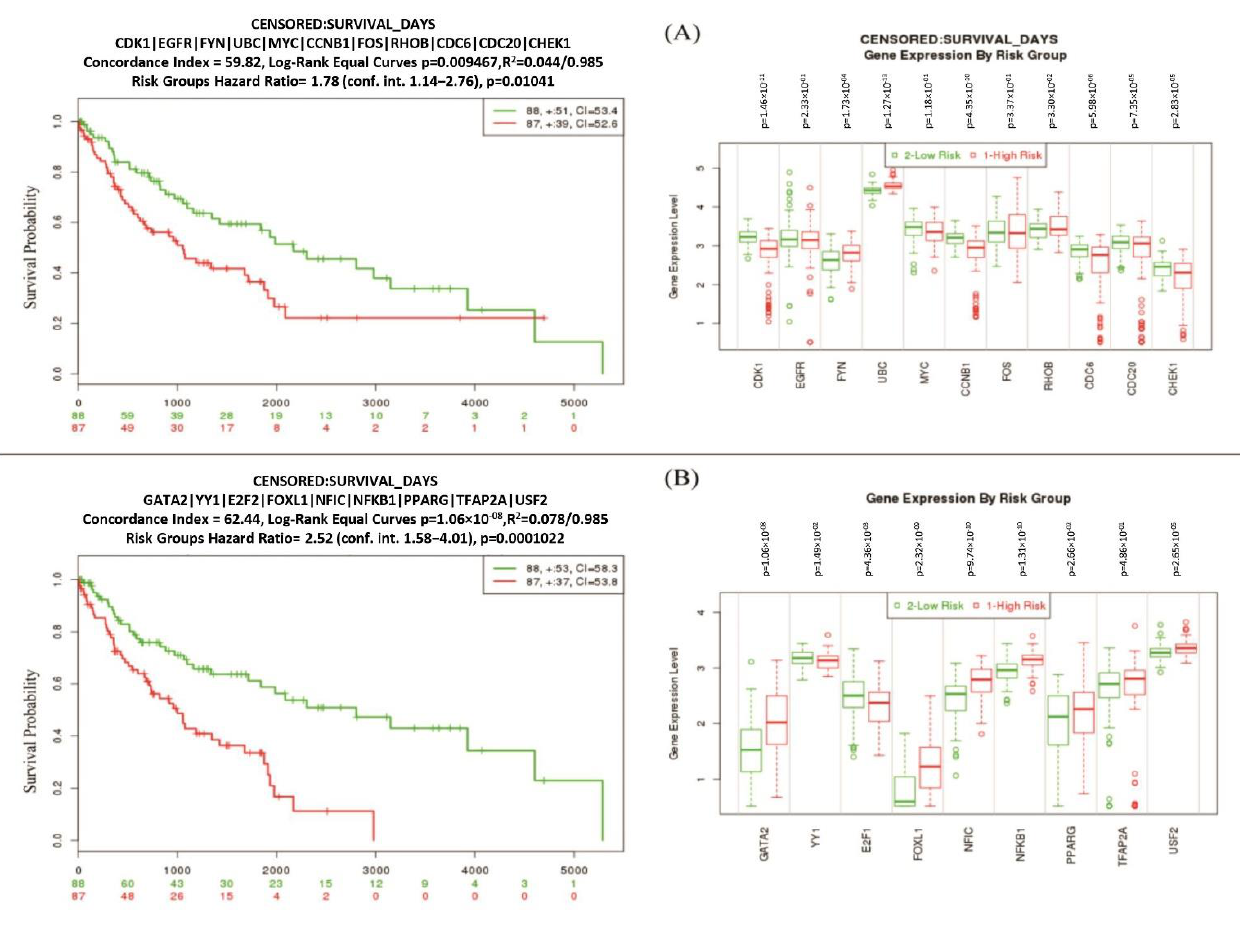
Table 3. The repurposed drugs that were found from the CMap database.